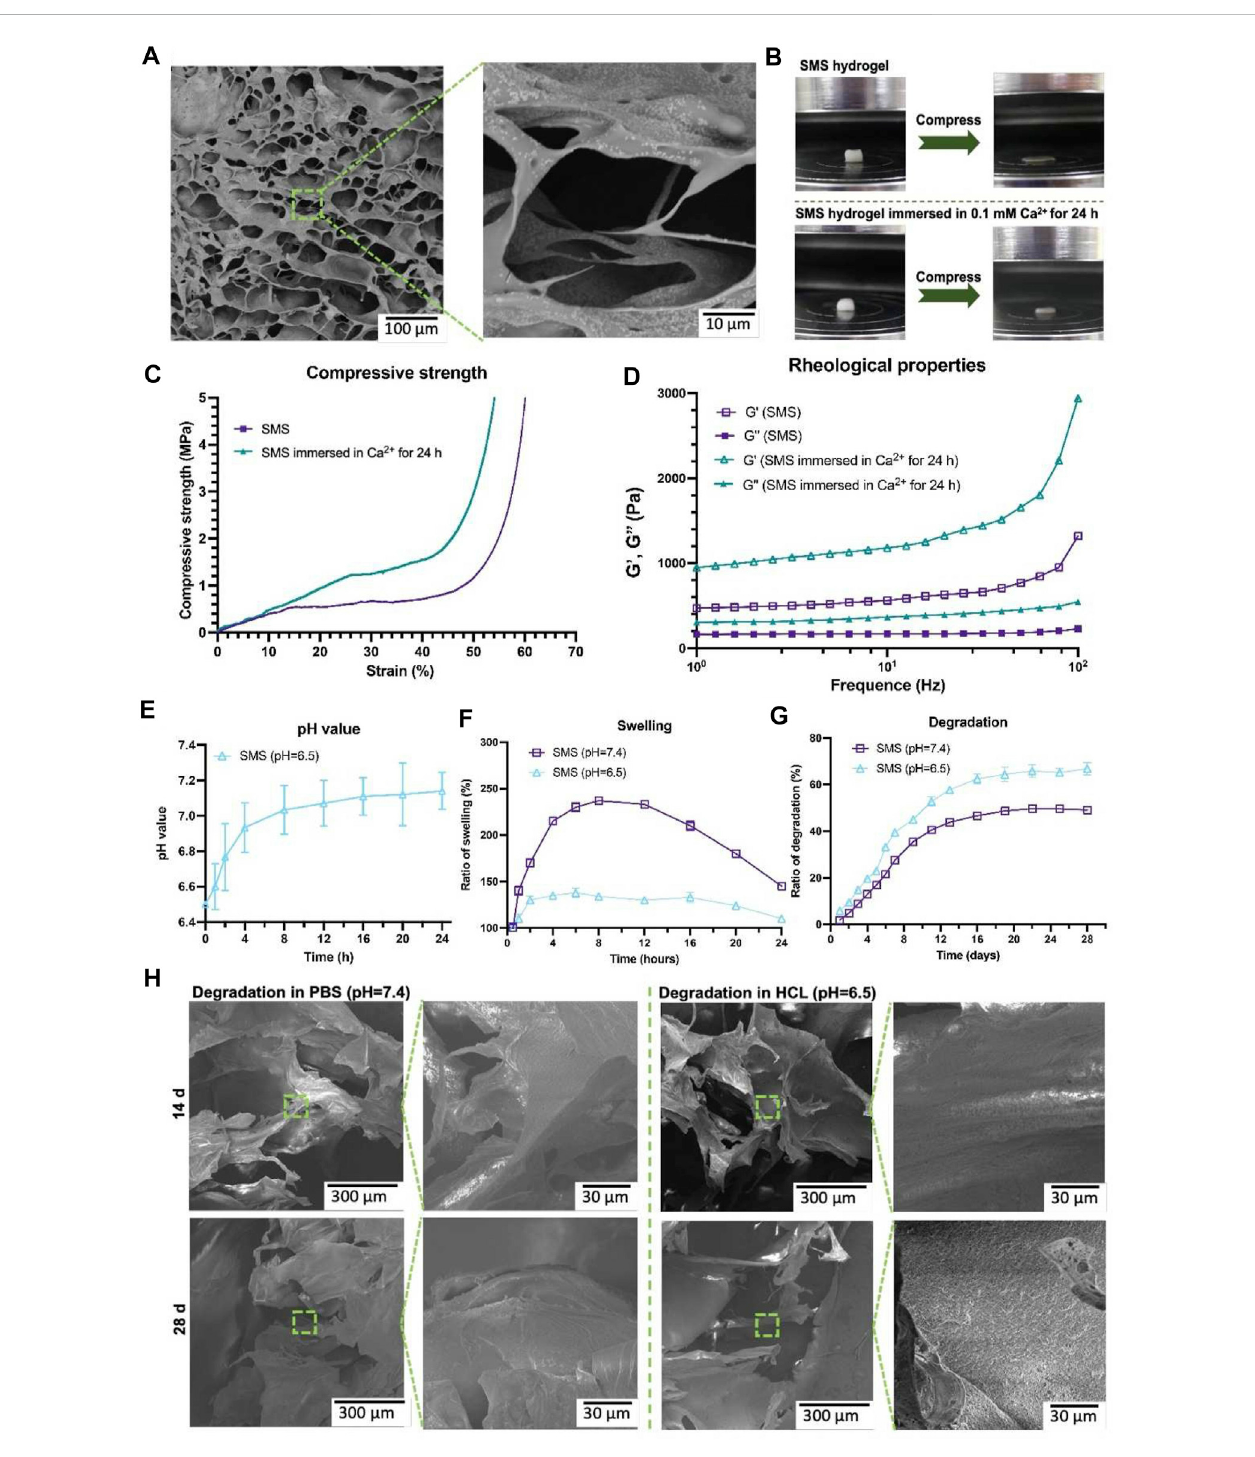
FIGURE 2 Microstructure of SMS hydrogel under SEM (A) . Compression testing diagram (B) . Strain curves of SMS hydrogel under different Ca 2+ conditions (C) . Rheological behavior of SMS hydrogel under different Ca 2+ conditions (D) . Effect of SMS hydrogel on PH value in HCl environment (E) . Swelling of SMS hydrogel under different PH conditions in vitro (F) . Degradation of SMS hydrogel under different PH conditions in vitro (G) . Microstructure of hydrogel under SEM in different PH conditions (H) . SMS: silk fi broin/mesoporous bioglass/sodium alginate. Reproduced with permission from (Zheng et al.,